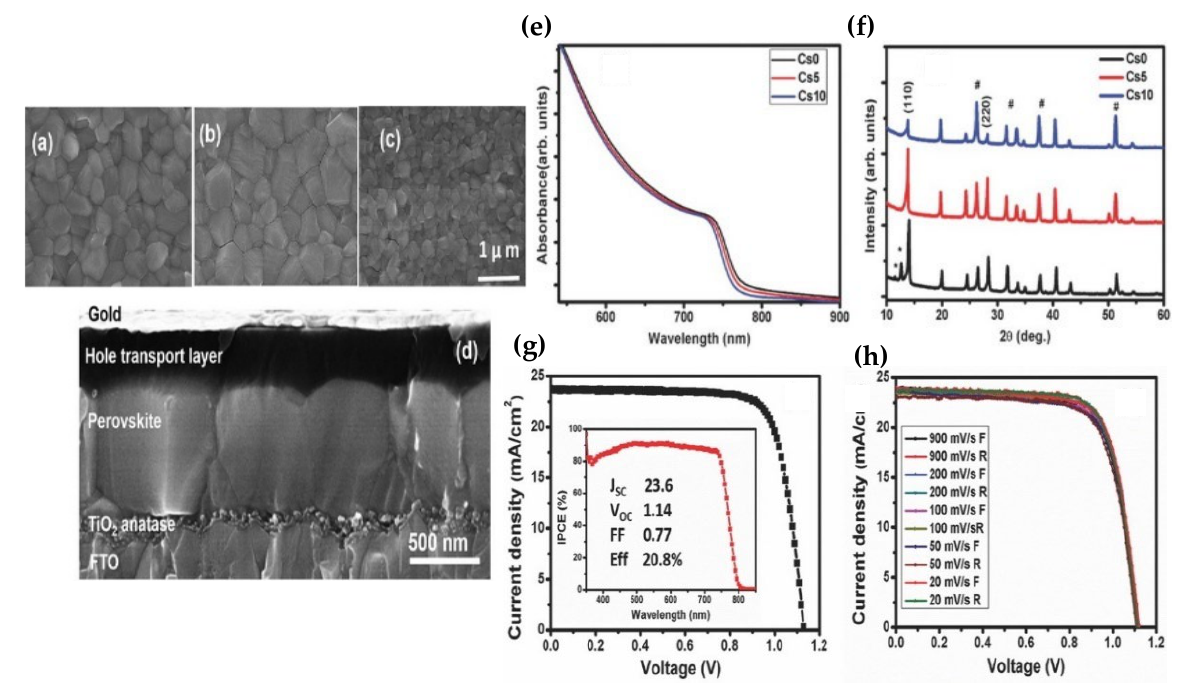
Figure 8. Characterized performance of triple cation perovskite solar cell. ( a – d ) SEM micrographs images; ( a ) Cs0/MA/FA, ( b ) Cs5/MA/FA; ( c ) Cs10/MA/FA; ( d ) cross sectional area at Cs5/MA/F; ( e ) absorption spectrum; ( f ) XRD pattern of Cs/MA/FA at 0, 5 to 10 wt% Cs addition; ( g , h ) I–V and IPCE curves [48].